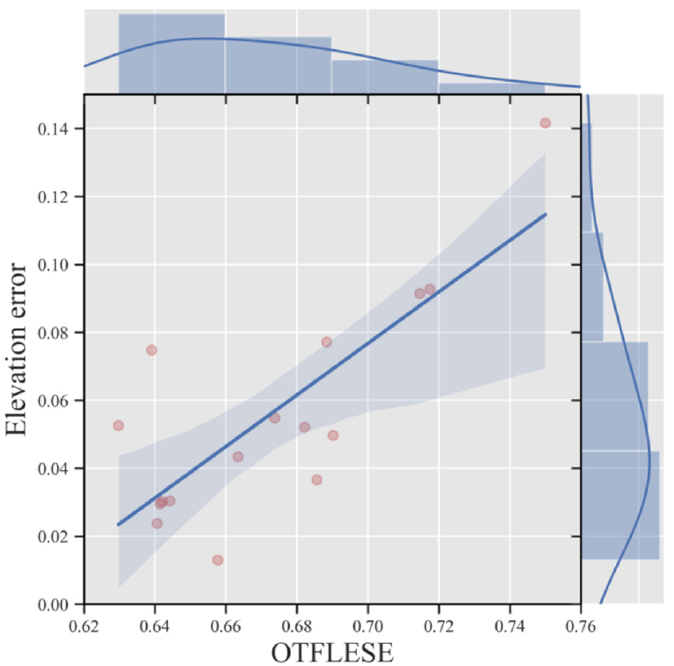
Figure 11. Correlation analysis between the optical transfer function (OTF)-laser emission state evaluation (LESE) and altimetry error.